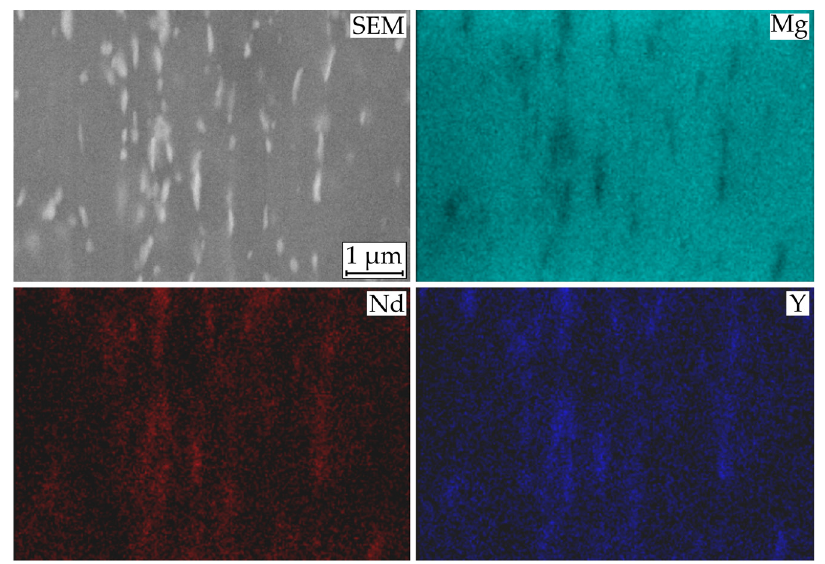
Figure 3. Longitudinal microstructure of WE43 with EDS mappings of magnesium (Mg), neodymium (Nd), and yttrium (Y). Investigations performed with a focused ion beam scanning electron microscope (FIB-SEM, Crossbeam XB 550L, Carl Zeiss AG, Oberkochen, Germany).